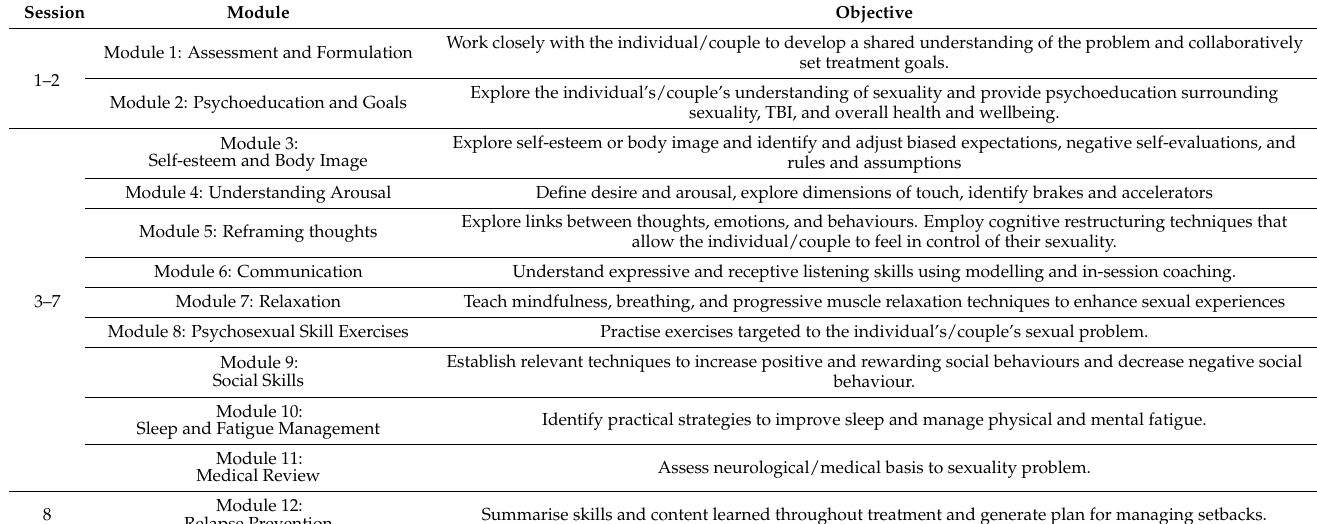
Table 2. Treatment structure and